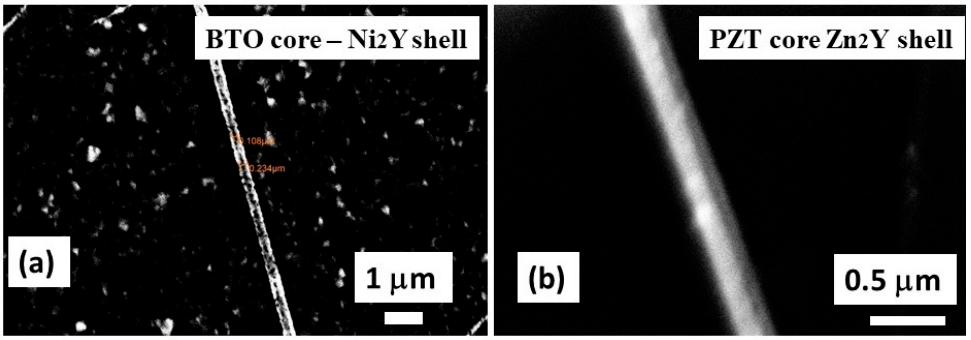
Figure 7. SEM images of ( a ) BTO core–Ni 2 Y shell and ( b ) Ni 2 Y core–BTO shell fibers spun under the electric field of 1.2 kV/cm and annealed at 900 °C.